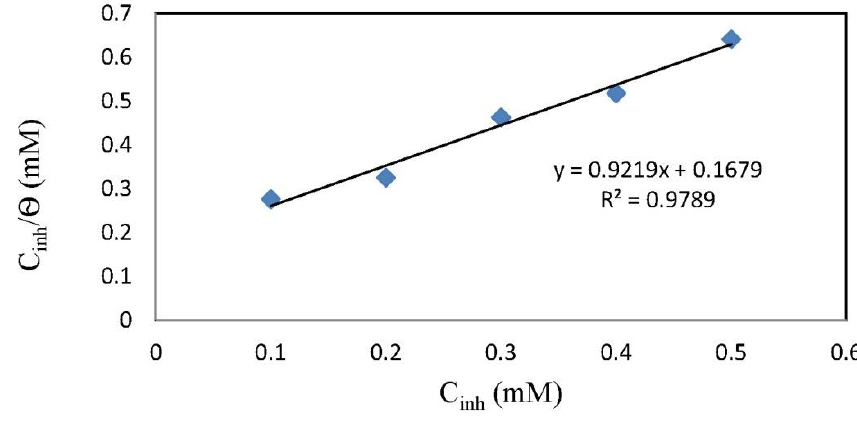
Figure 7. Adsorption isotherm for chlorocurcumin on the mild steel surface in 1.0 M